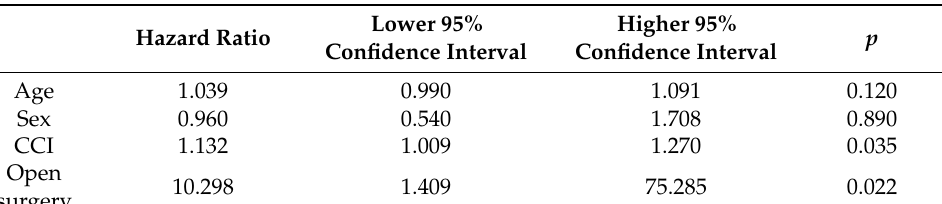
Table 2. Cox regression analysis showing that Charlson comorbidity index (CCI) and open surgery were independently associated with mortality during follow-up.